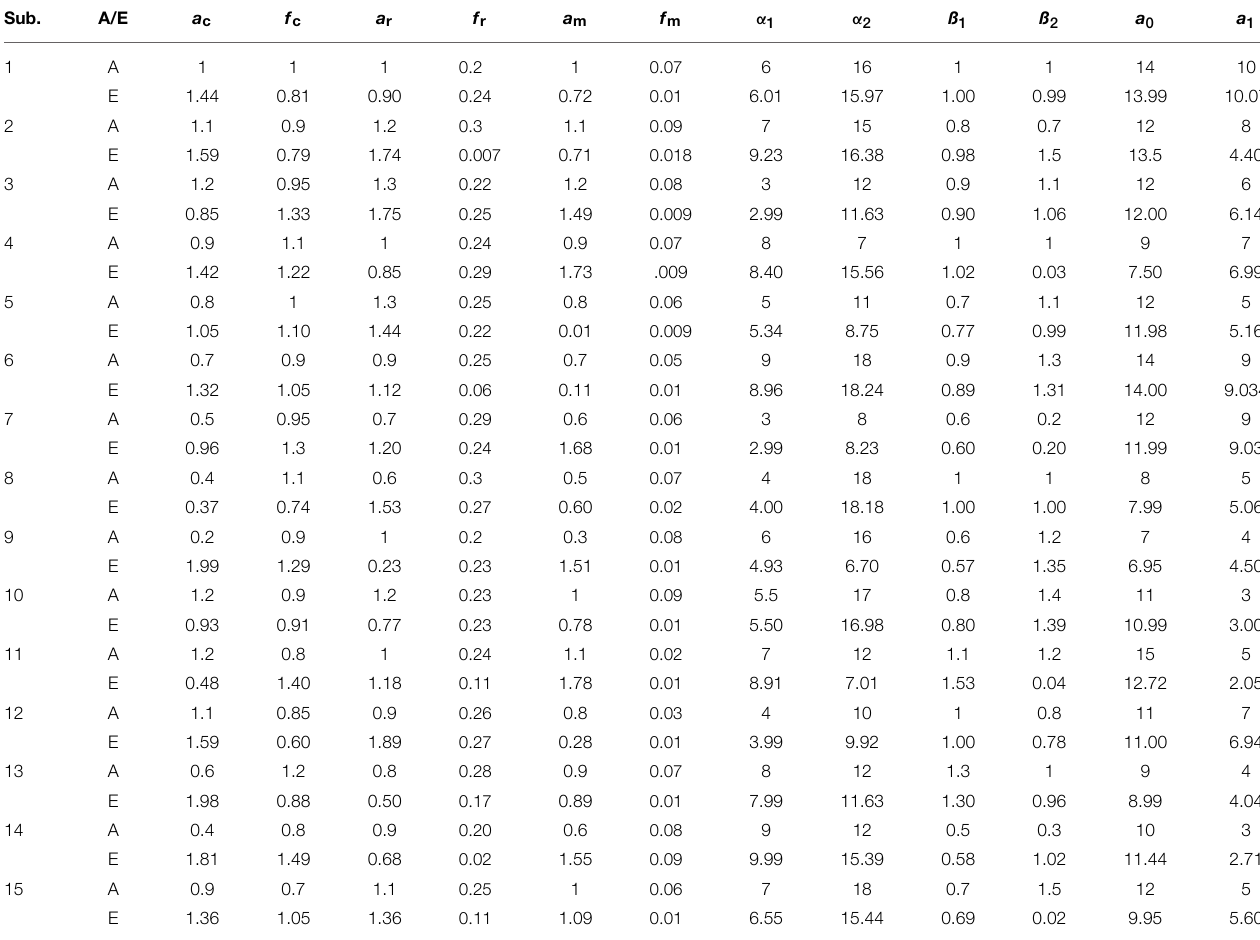
TABLE 1 | The results of 15 simulated data-sets: the actual values of parameters (A) and estimated ones through the proposed algorithm (E).